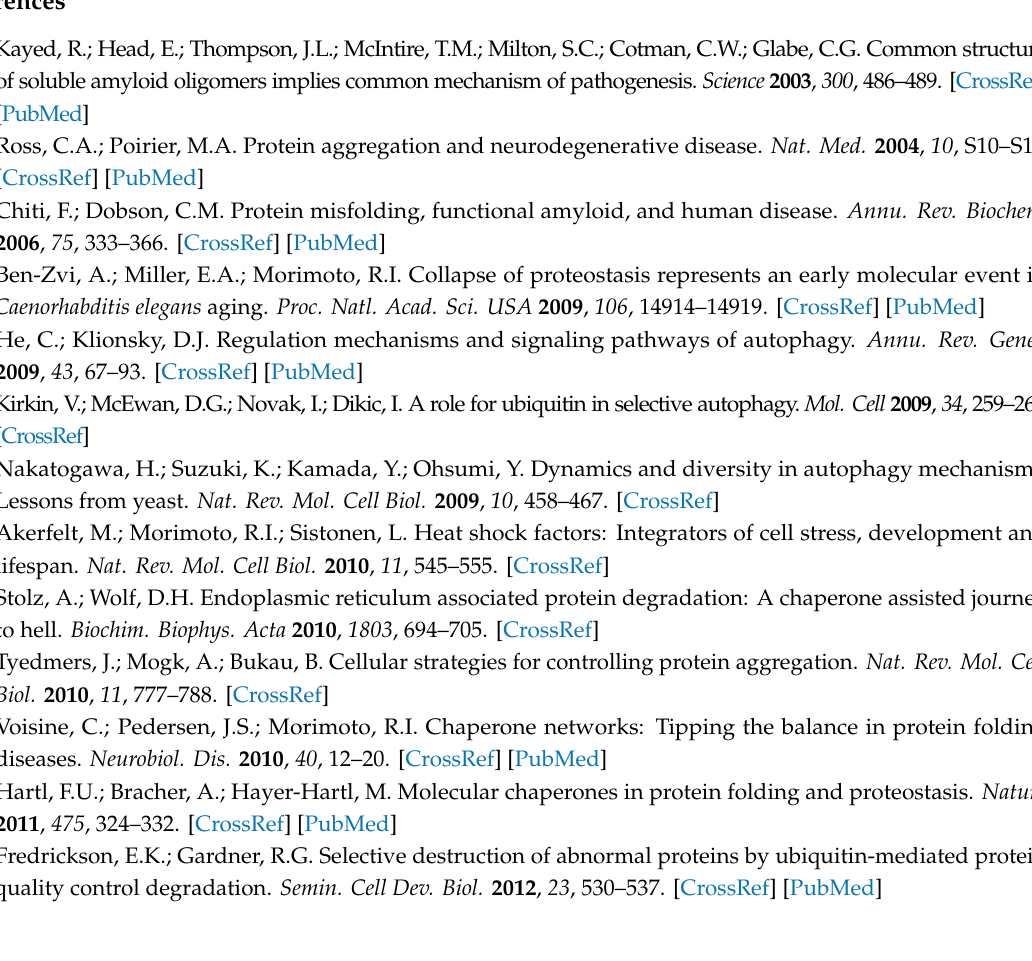
Figure S1: NTAN1 protein expression by the Rosetta 2(DE3) strain, Figure S2: The catalytic triads of NTAN1 and three other proteins structurally similar to NTAN1, Figure S3: Deamidation of pentapeptides catalyzed by NTAN1, Figure S4: Sequence alignment of NTAN1s from seven representative organisms, Figure S5: Superposition of wild-type NTAN1 and the NTAN1 C75S mutant structures, Figure S6: Substrate-recognition mode of NTAN1, Figure S7: Proposed catalytic mechanism of NTAN1, Table S1: Data collection and refinement statistics of NTAN1 structures, Table S2: Optimized MS parameters and retention times of substrates